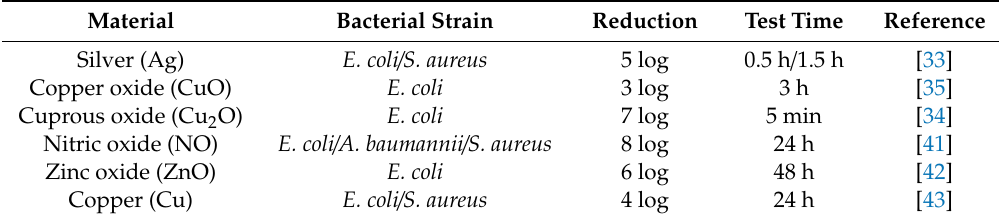
Table 1. Summary of common inorganic antimicrobial materials and their best antimicrobial activity reported in the